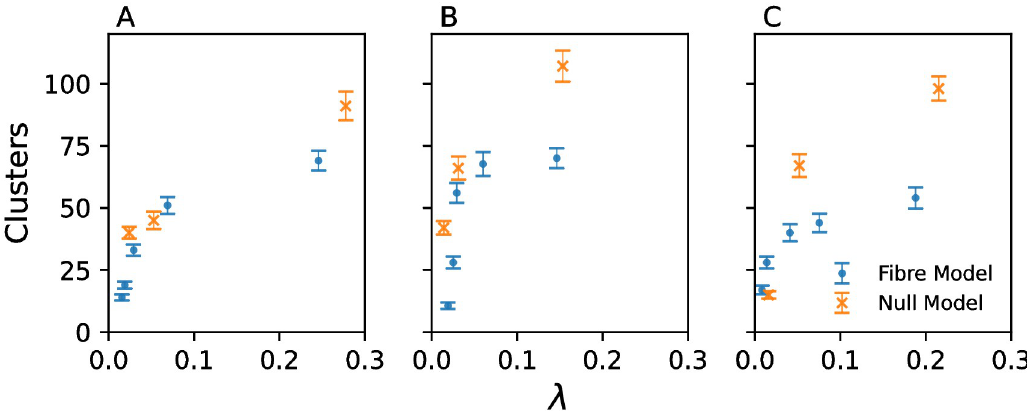
Fig 7. The number of independent spatial clusters identified as at local risk of micro-anatomical reentry. Data for the fibre model (blue points) and the fibre-less null model (orange crosses) for (A) the human atria, (B) the healthy sheep atria, and (C) the HF sheep atria, as a function of the global risk parameter, λ . Each clustering value is calculated from 1000 sampled micro- reentrant circuits. Error bars from